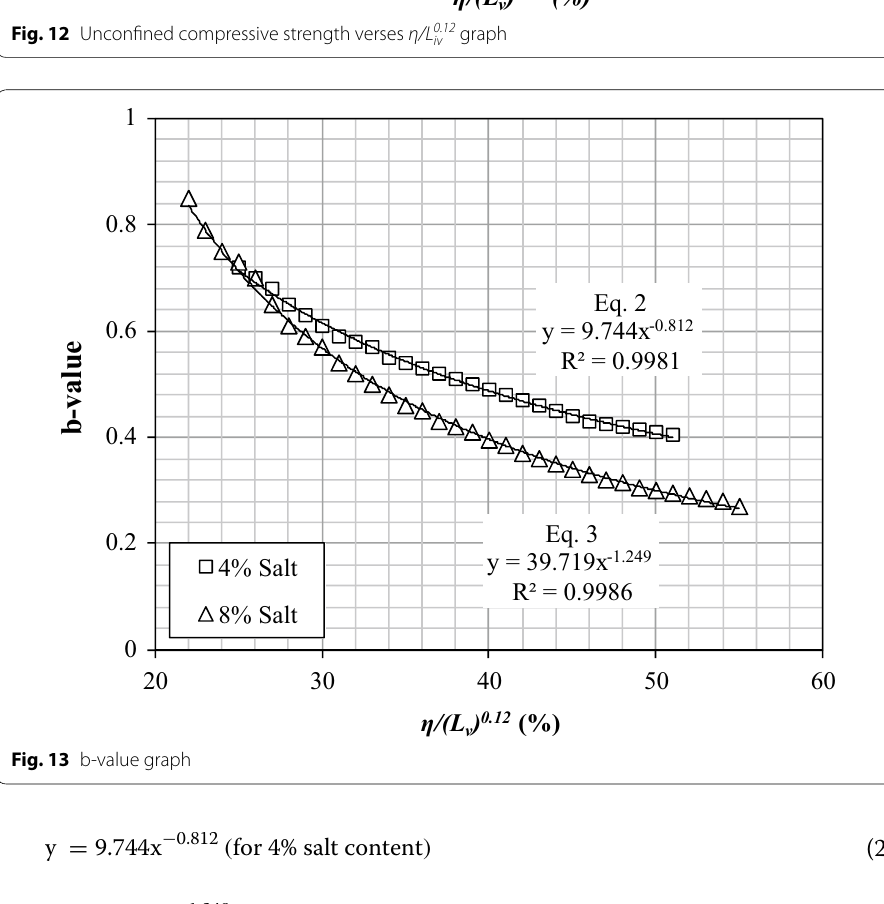
Fig. 12 Unconfined compressive strength verses η/L iv0.12 graph